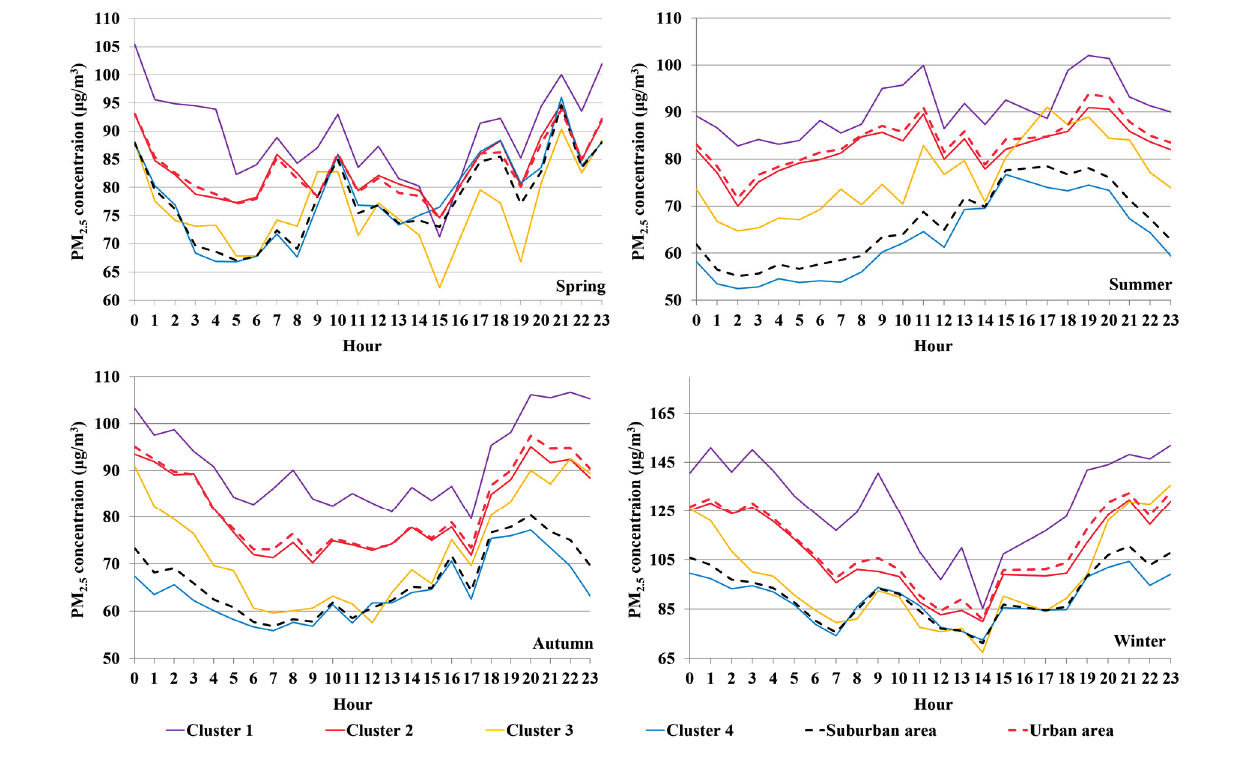
Figure 3. Similar diurnal pattern of PM 2.5 concentration at all clusters. It is clear that urban areas have higher PM 2.5 concentration than suburban. Cluster 1 always suffers the highest PM 2.5 concentration and cluster 4 mostly enjoys the minimum